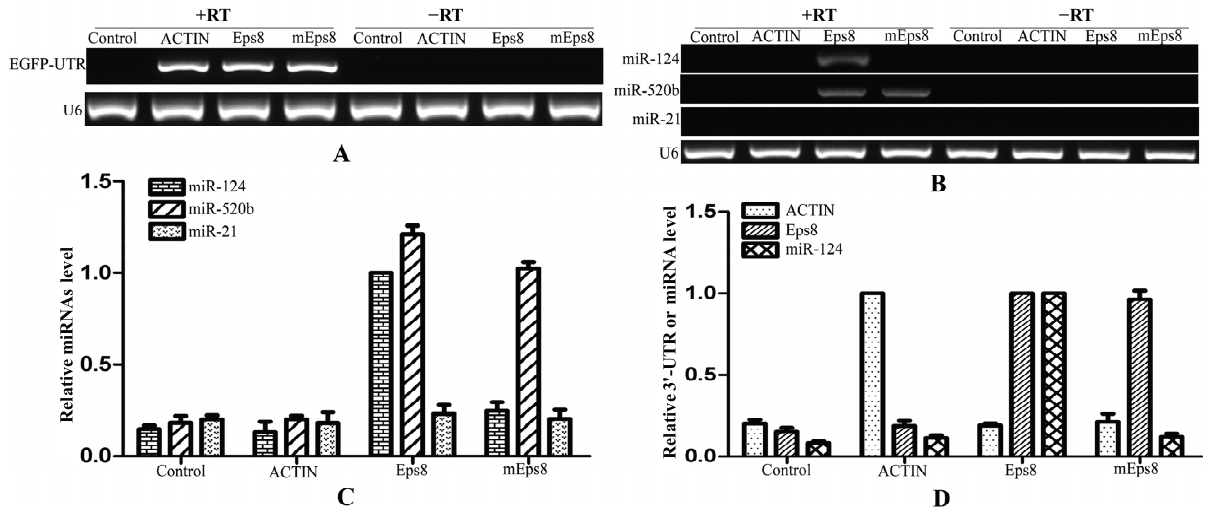
Figure 6. mRNA:miRNAs isolation technique for Eps8 and its target miRNAs. ( A ) The enrichment of RNA chimeric mRNAs of EGFP -3'-UTR demonstrated the efficiency of isolation technique; ( B ) The regulated miRNAs of Eps8 were obtained from the product that was transfected with 3'-UTR-Eps8 through semi-quantitative PCR. At the same time, miRNAs that without binding sites could not be amplified from these products; ( C ) The levels of detected miRNAs were verified using qRT-PCR after the process of isolation technique; and ( D ) qRT-PCR showing the relationship between mRNA and their target miRNA after the isolation. RT: Reverse